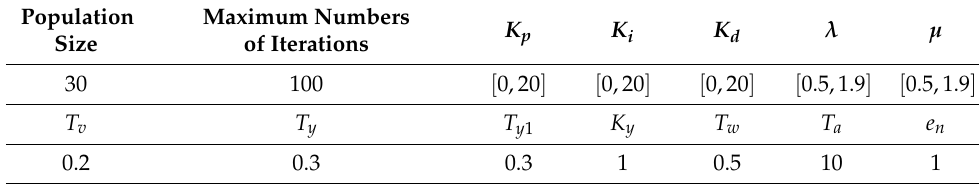
Table 8. The specific experimental settings and parameter values.